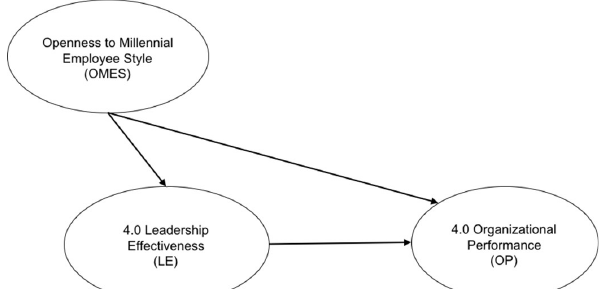
Fig. 1. A model linking openness to millennial style to 4.0 leadership effectiveness and 4.0 organizational performance